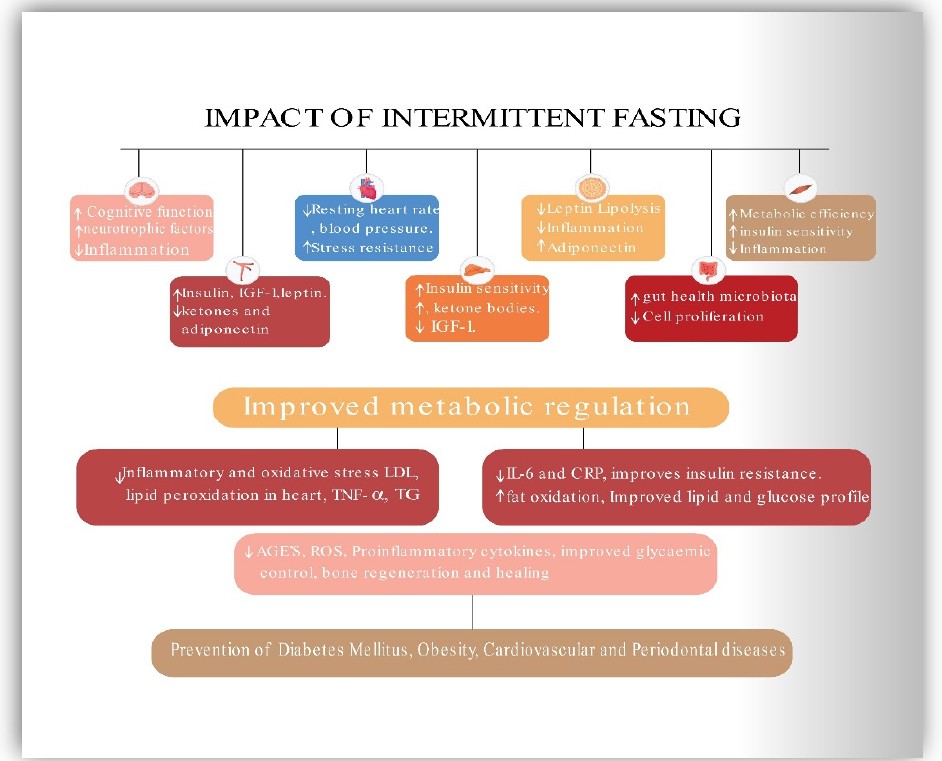
Figure 5. Schematic representation of the beneficial role of Intermittent fasting in preventing chronic diseases. IGF-1—Insulin-like growth factor, AGE’S—Advanced glycation end product, ROS—Reactive oxygen species, IL-6 Interleukin-6, CRP—C-reactive protein, LDL—low-density lipoprotein, TG—triglycerides.